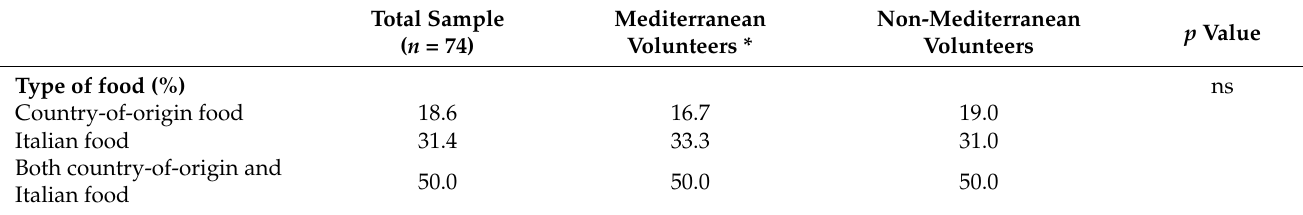
Table 4. Type of food habitually consumed by geographical area of